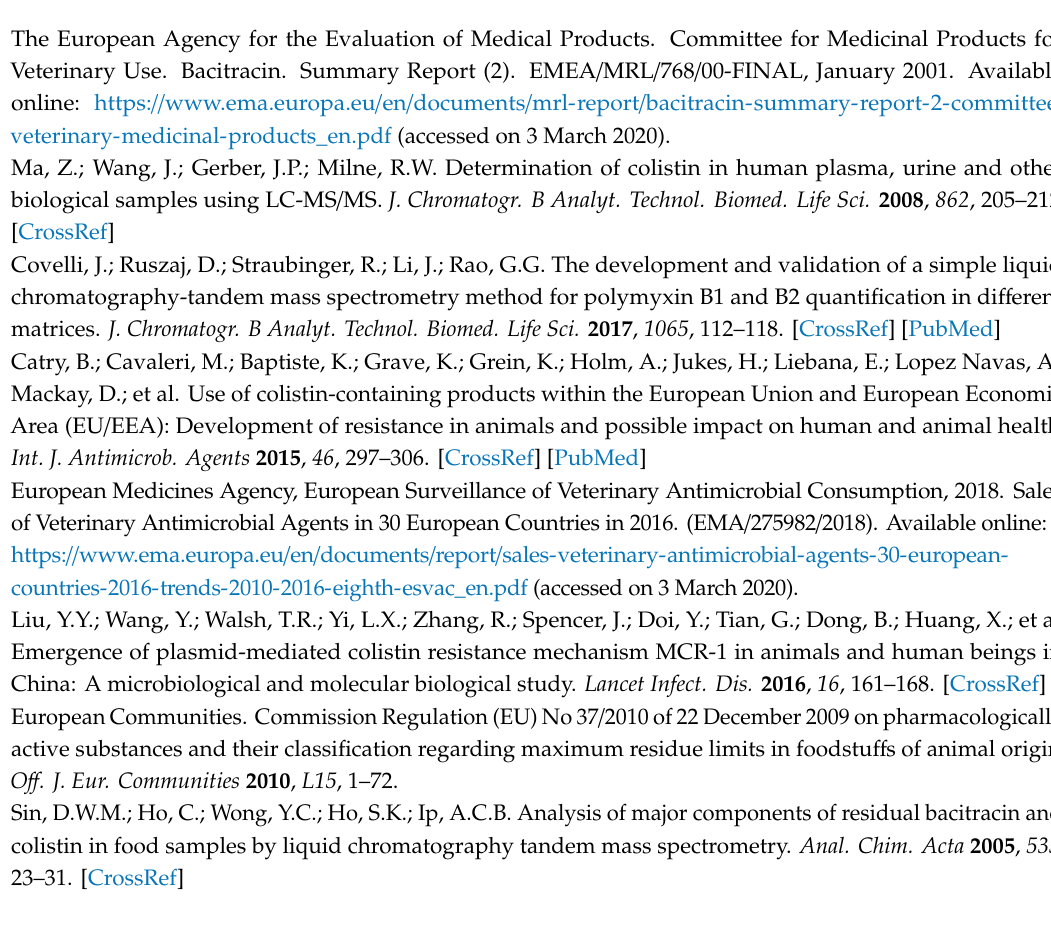
compounds. Table S2: Some physicochemical properties of studied compounds [28]. Table S3: Variables and their levels in the Youden ruggedness test experimental design. Table S4: Statistical evaluation of ruggedness test results (seven factors, eight experiments) for muscle samples. Table S5: Preparation of the calibration curves and the spiked